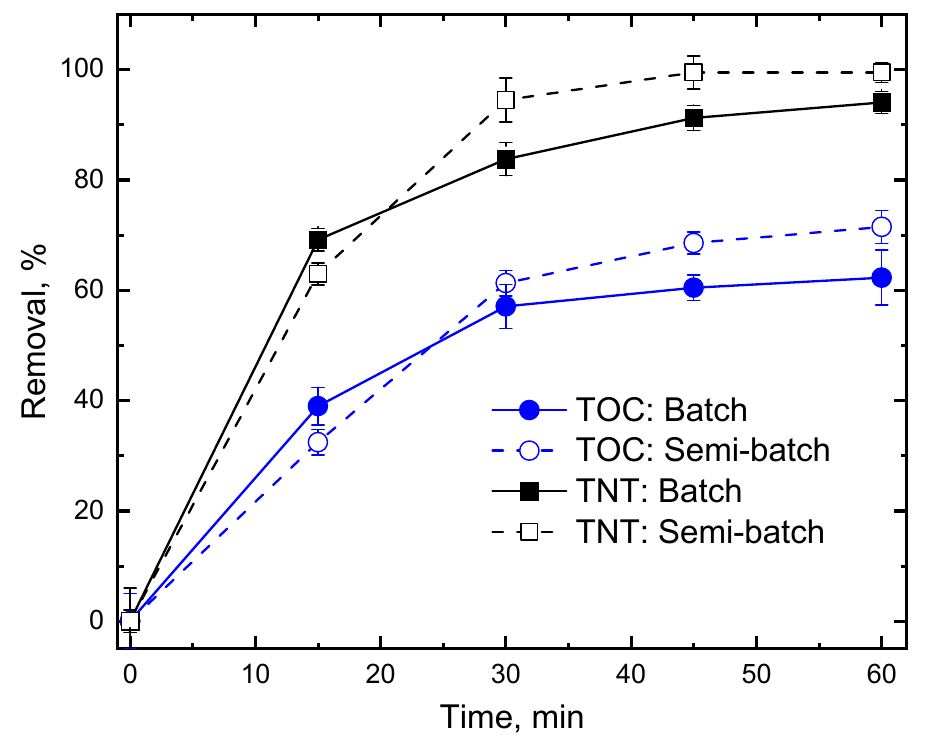
Figure 5. Removal of TNT and TOC by batch and semi-batch mode reactor. Experimental condition: (TNT) 0 = 30 mg/L, (NaCl) = 10 − 2 M, Initial pH = 3.0 ± 0.1, Temperature = 25 °C, US intensity = 8571W/m 3 , Reaction time = 60 min, Batch: (Fe 2+ ) = 5 × 10 − 4 M, (H 2 O 2 ) = 5 × 10 − 3 M, Semi-batch: Dosing rate of Fenton reagents: (H 2 O 2 ) = 2.5 × 10 − 6 mol/min, (Fe 2+ ) = 2.5 × 10 − 7 mol/min.